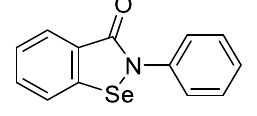
Figure 1. Ebselen.